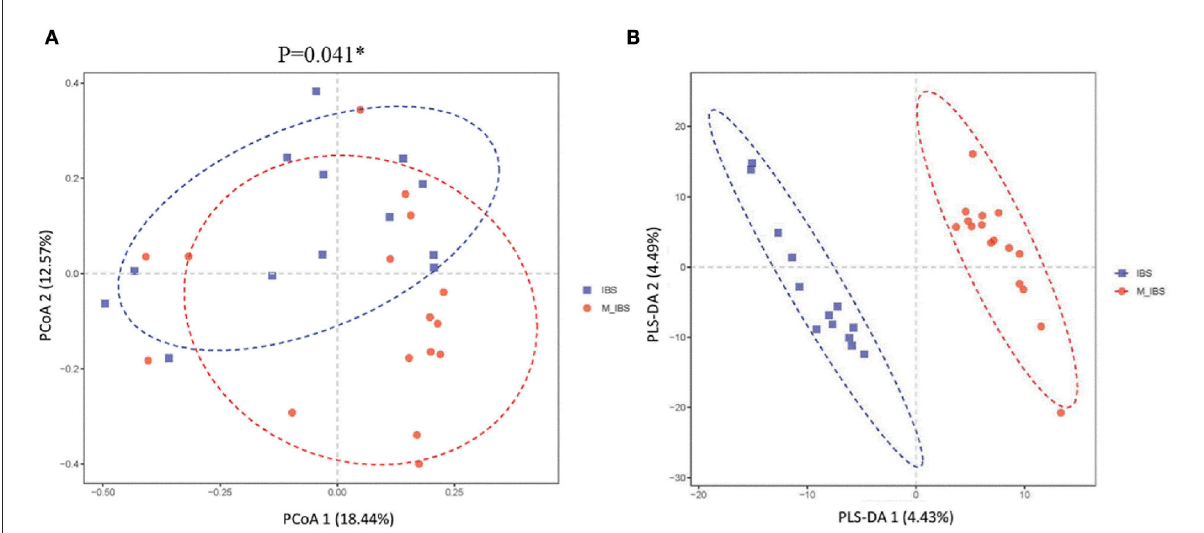
FIGURE2 β -diversity indices of gut microbiota in the M_IBS and IBS groups. Differences in beta diversity indices between the M_IBS and IBS groups were measured using PCoA based on Bray–Curtis (A) and PLS-DA (B) , and significant P -values are indicated. The axes represent the two dimensions explaining the greatest proportion of variance in the communities. Each symbol represents a sample, and the points of different colors or shapes in the figure represent different groups. The scales on the horizontal and vertical axes are relative distances, while PCoA 1, PCoA 2, PLS-DA 1, and PLS-DA 2 represent the suspected influencing factors for the deviation of the microbial composition of the two groups of samples. M_IBS, migraine with irritable bowel syndrome; IBS: irritable bowel syndrome; OUT, operational taxonomic unit; PCoA, principal coordinates analysis; PLS-DA, partial least squares discrimination